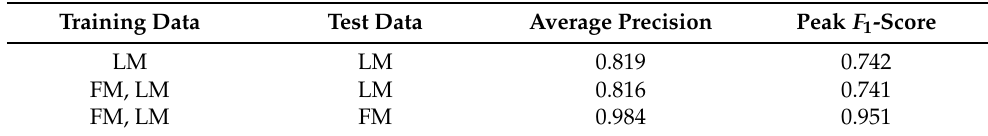
Table 2. Performance study on lip